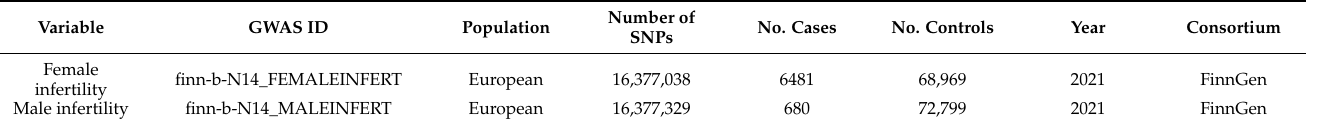
Table 1. Summary of